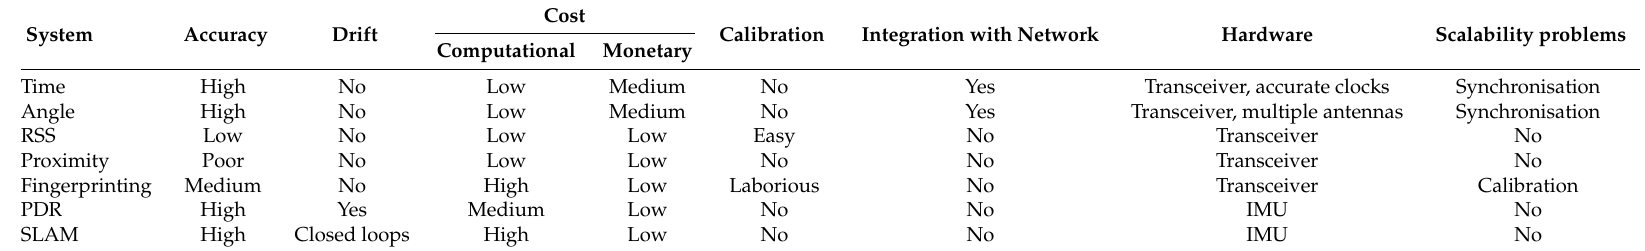
Table 2. Comparison of Indoor Positioning Systems.